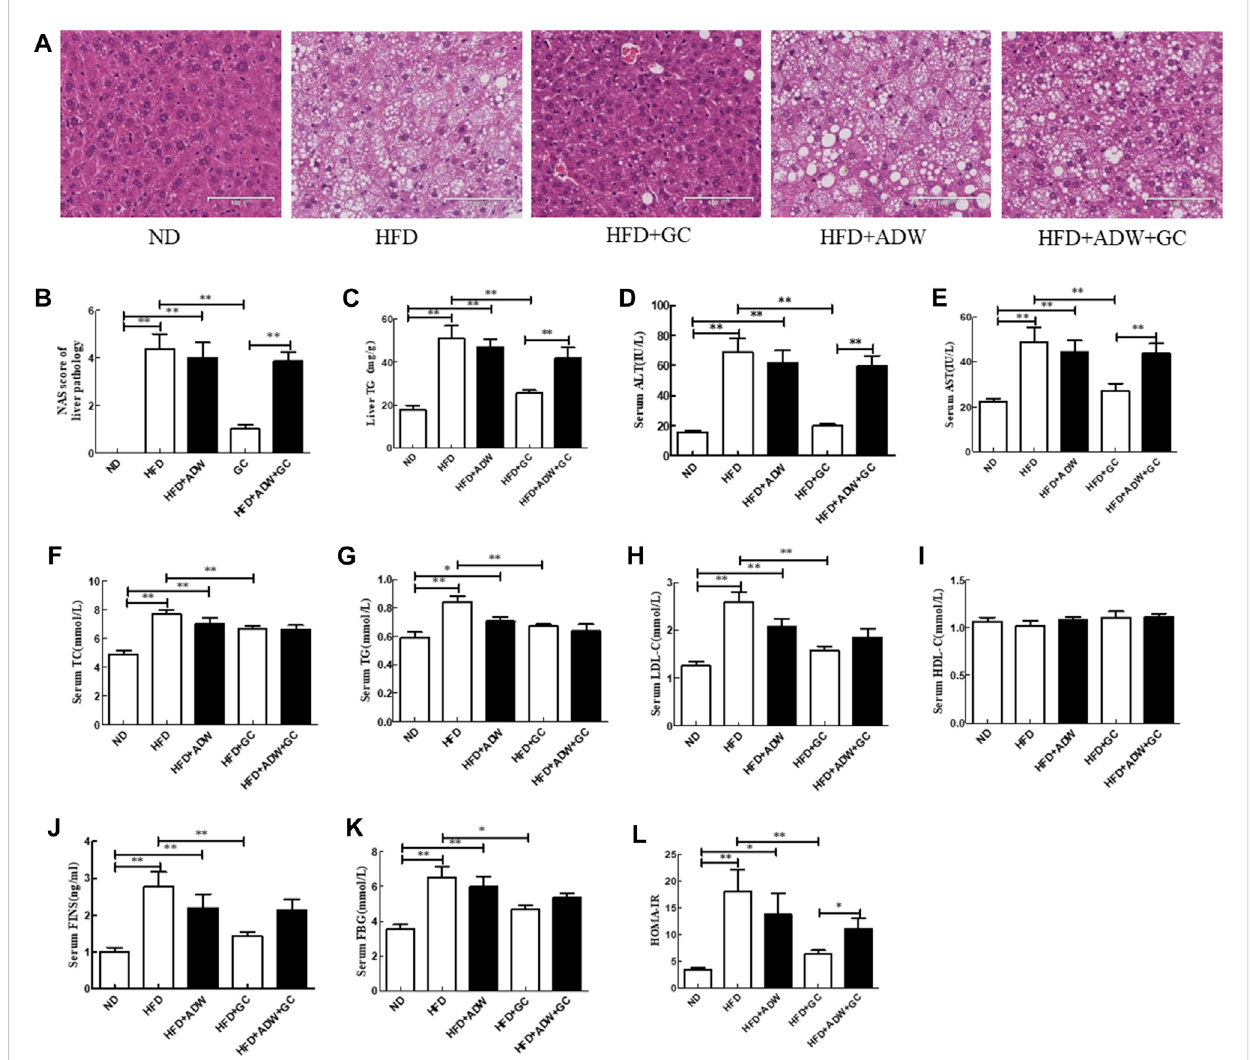
FIGURE 2 Changes in liver histology and biochemical indexes of liver and serum in a mouse NAFLD model and intervention with GC with or without ADW. (A) H&E staining, ×200. (B) Liver NAS. (C) Liver TG level. (D) Serum ALT level. (E) Serum AST level. (F) Serum TC level. (G) Serum TG level. (H) Serum LDL-C level. (I) Serum HDL-C level. (J) Serum FINS level. (K) Serum FBG level. (L) HOMA-IR. Abbreviations: NAFLD, non-alcoholic fatty liver disease; ND, normal diet; HFD, high-fat diet; ADW, antibiotic drinking water (containing ampicillin, neomycin, vancomycin, and tinidazole); GC, geniposide and chlorogenic acid combination treatment; NAS, NAFLD activity score; H&E, hematoxylin and eosin; TG, triglyceride; ALT, alanine aminotransferase; AST, serum aspartate aminotransferase; TC, total cholesterol; LDL-C, low-density lipoprotein cholesterol; HDL-C, high-density lipoprotein cholesterol; FINS, fasting insulin; FBG, fasting blood glucose; HOMA-IR, Homeostatic Model Assessment of Insulin Resistance. * p < 0.05 and ** p < 0.01 ( n = 8 per